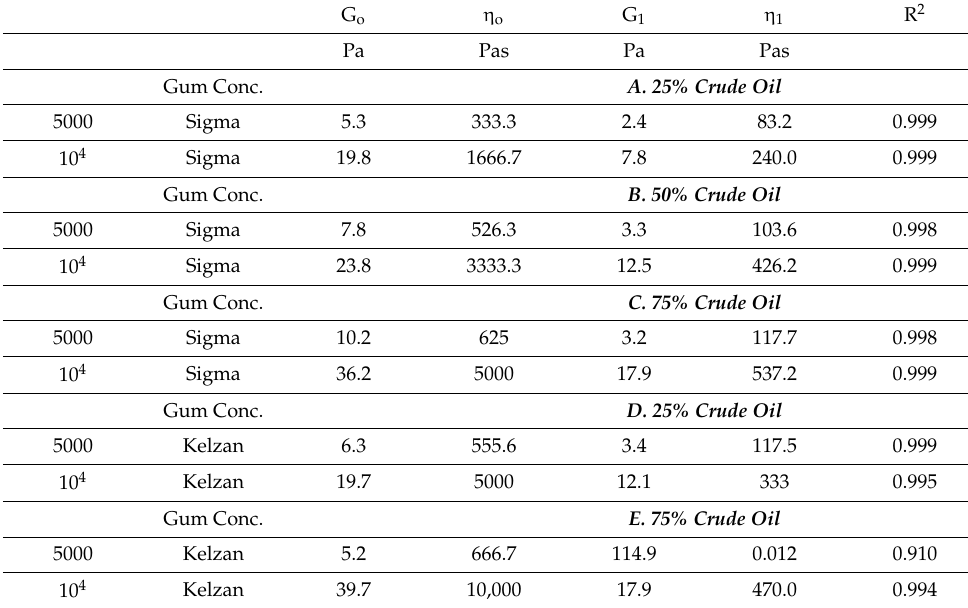
Table 3. Creep modelling using Burger equation for higher gum emulsions. G o